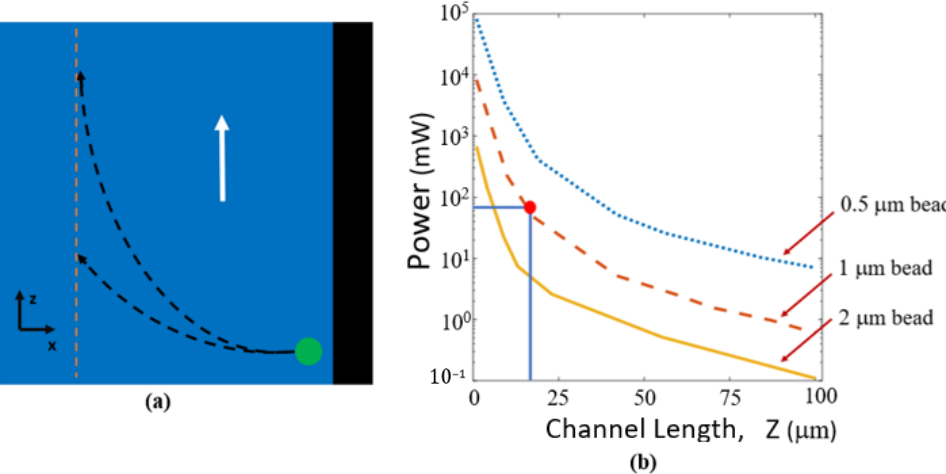
Figure 8. ( a ) Illustration of possible particle paths (black dotted arrows) for the worst-case scenario when a particle is at the edge of the channel at a side wall. The magnitude of the gradient force will determine how quickly a particle will become centralized. The particle is represented by the green circle. The channel center is shown by the orange dotted line. Fluid flow is in the direction of the white arrow. ( b ) Optical power required for minimum centralizing gradient force versus channel length for various particle diameters based on Equations (2) and (3). Solving Equation (3) provides solutions that can be used to determine how far along the channel in the z direction the particle will travel before becoming centralized. The intersecting lines and dot representing the conditions used when experimentally testing the platform with a 1 μ m bead.